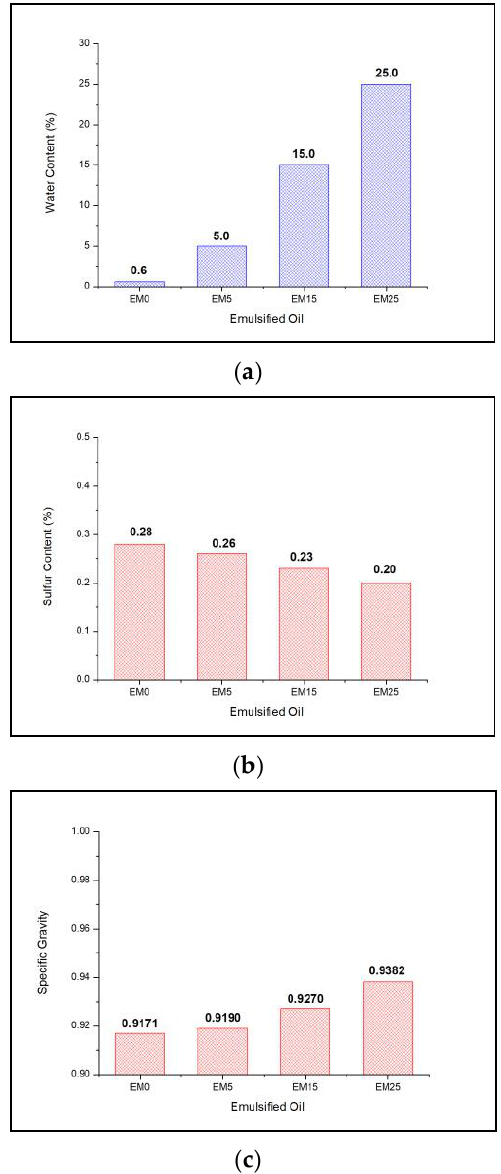
Figure 7. Fuel composition comparison of emulsified oils: ( a ) water content, ( b ) sulfur content, and ( c ) specific gravity.